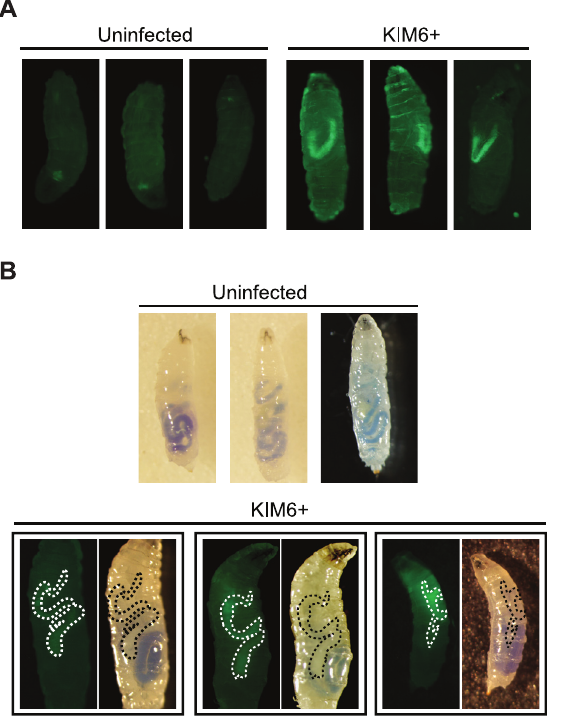
Fig 2. Localization of Y . pestis within an infected larva. (A) The KIM6+ GFP reporter strain (10 9 CFU) was used to infect larvae, and bacterial localization was visualized using fluorescence microscopy. Representative images from three different larvae are shown (n > 30 from at least three independent trials). (B) Larvae were infected as in panel A, except that 0.05% bromophenol blue and 5% sucrose were included in the larval food in order to visualize regions of the gut. Acidic = yellow; neutral = clear; alkaline = blue. Larvae were imaged using standard bright field and fluorescence microscopy. Representative images are shown for uninfected (n = 28) and infected larvae (n = 25) from two independent trials. For infected larvae, dashed lines outline the bacterial niche, which was determined based on the GFP signal.